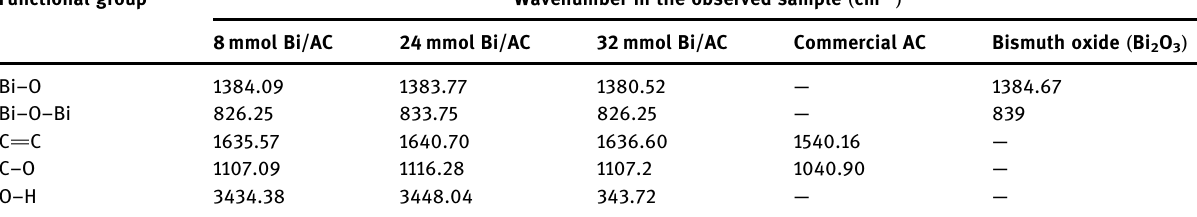
Table 1: Functional groups in the FTIR spectra Functional